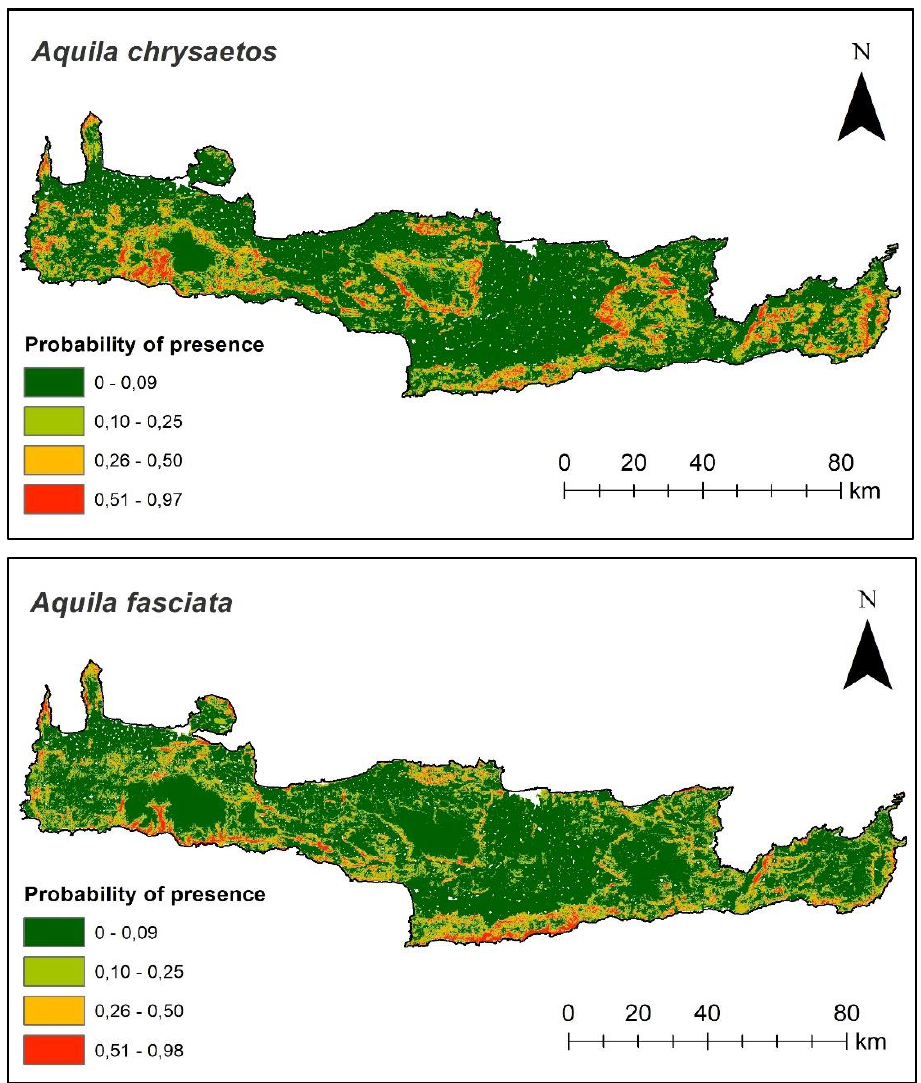
Figure 2. Nesting habitat suitability maps (predicted by a Maximum Entropy approach) and proba-